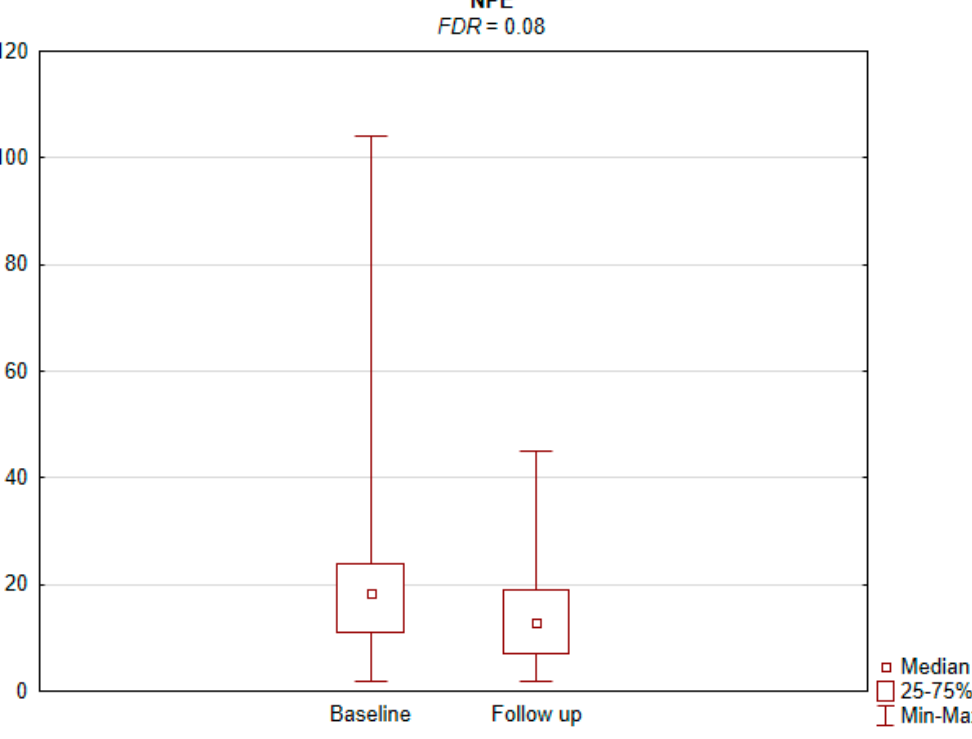
Figure 8. Non-perseverative errors (NPE) in Wisconsin Card Sorting Test before and after the intervention. FDR —false discovery rate.